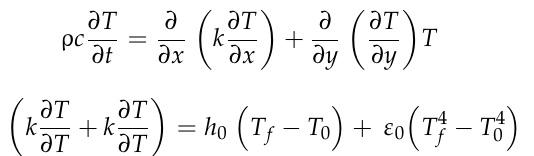
( b ) Figure 7. High-temperature localized heating element. ( a ) Overall view. ( b ) Open view. The weight of the column specimens was recorded before and after heating the spec- imens. Similarly, a nondestructive test was performed before and after heating the speci- mens to check the changes in the internal characteristics. The natural frequency was meas- ured through ambient vibration measurements for the fire-affected columns to identify the changes that occurred in the dynamic nature of the specimens after fire exposure. After that, the ultimate load capacity of the column specimens was identified by applying axial load to the specimens, and structural parameters were observed. 3. Optimization through Finite Element Analysis Transient analysis was performed for the conventional column and columns with 12 different geometries, and the inner core temperature was recorded with respect to the height. The comparison of the core temperatures with respect to the height for the columns